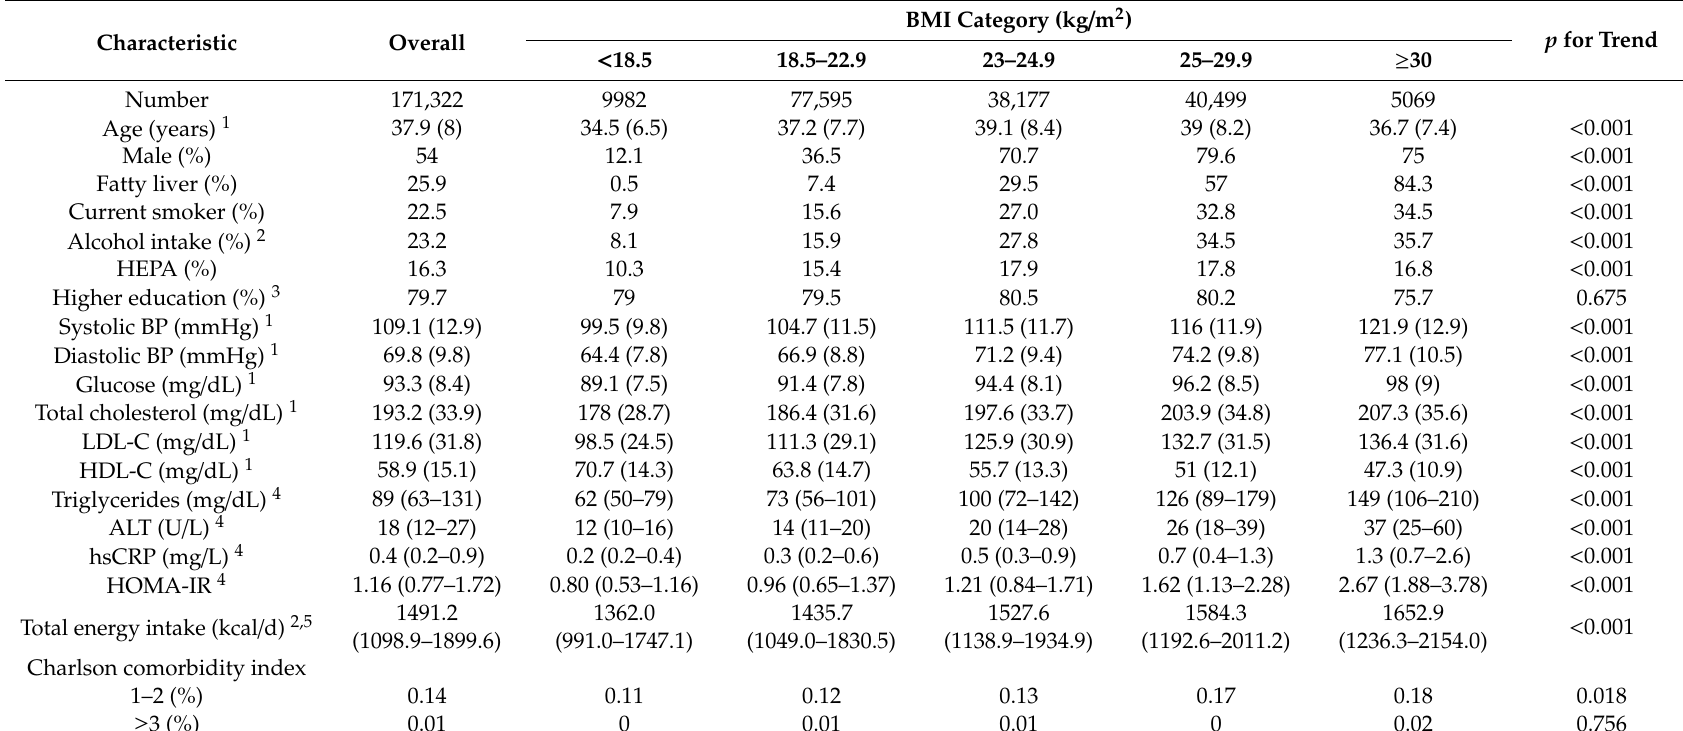
Table 1. Baseline characteristics of study participants by body mass index